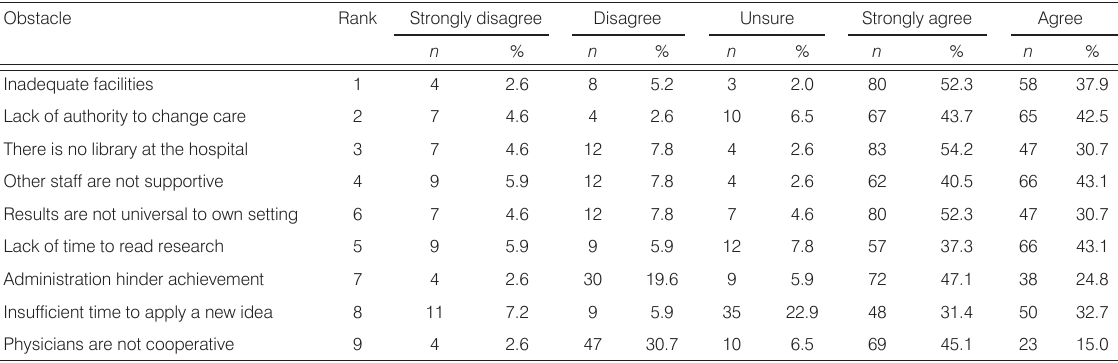
Table 3. Distribution of study sample regarding organizational limitations (N=154).